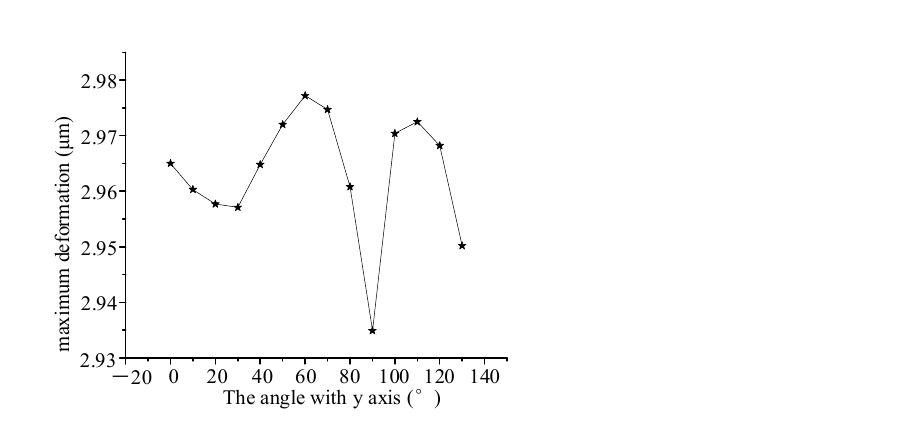
Figure 10. The maximum deformation at different loading positions under milling condition.